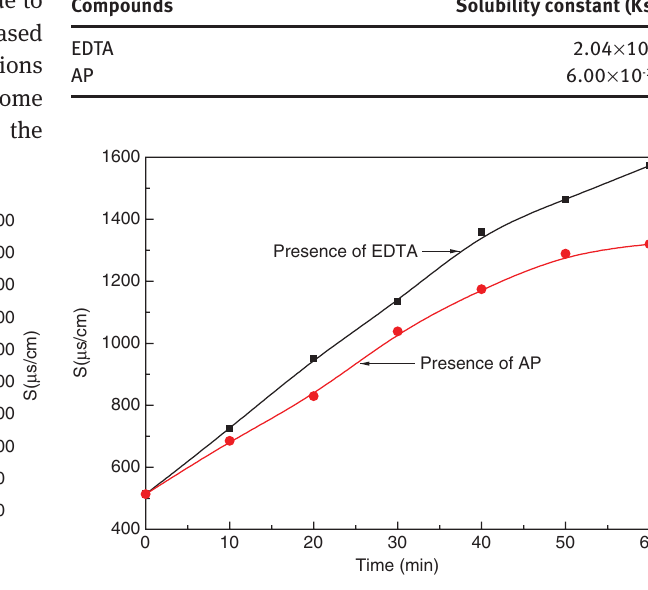
Figure 3: Changes of pH and electrical conductivity of untreated MgO with time.